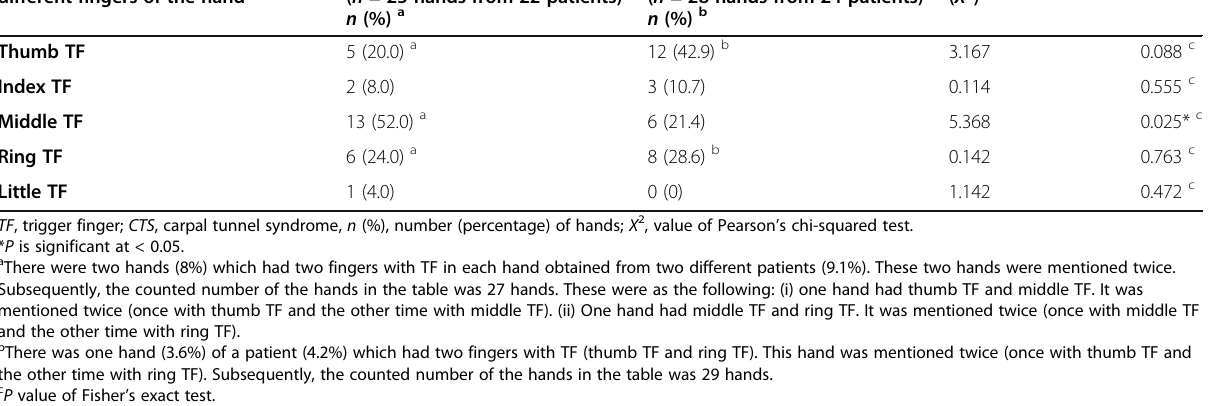
P Test of significance ( X 2 )